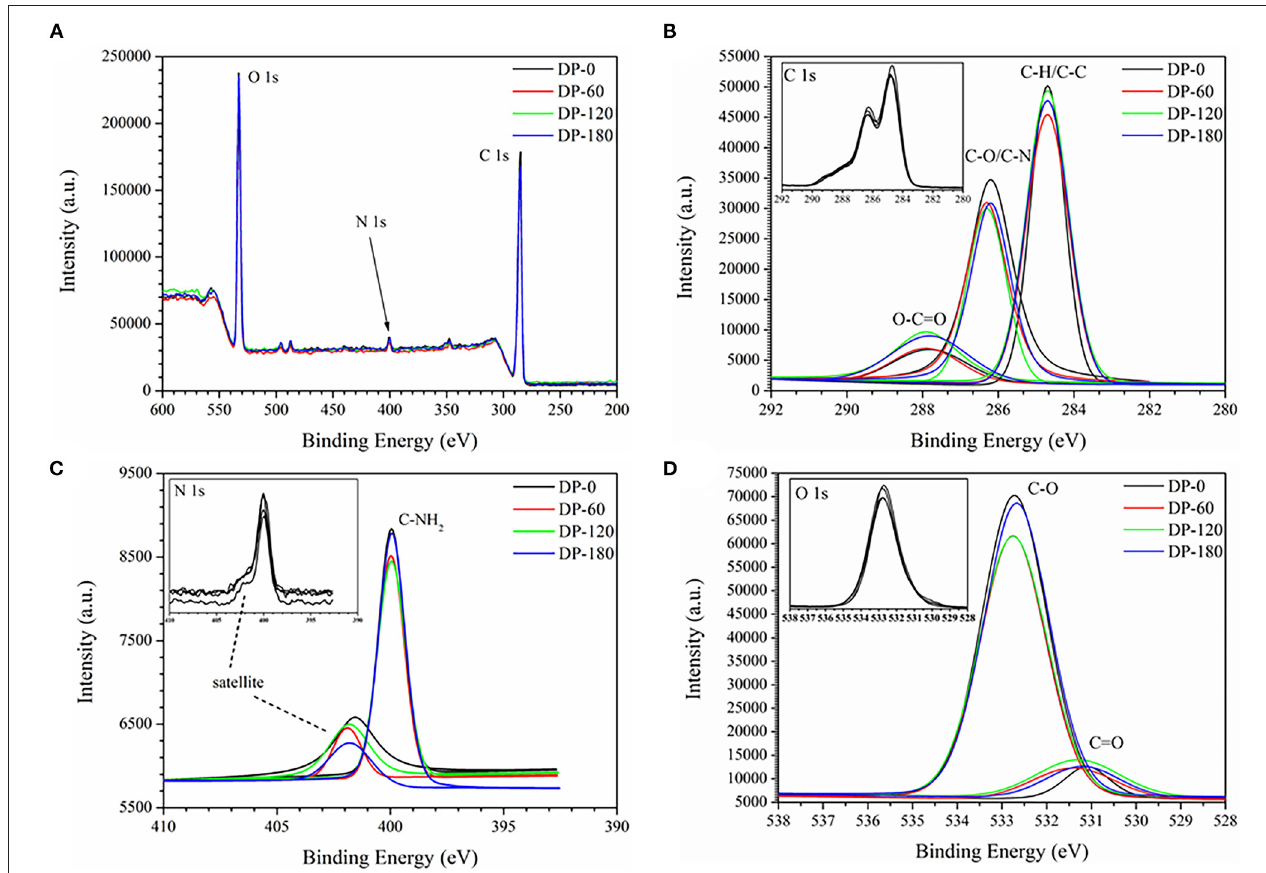
FIGURE 6 | The XPS survey spectra (A) and C 1s (B) , N 1s (C) , and O 1s (D) spectra of RPA in the DP-0, DP-60, DP-120, and DP-180 groups.